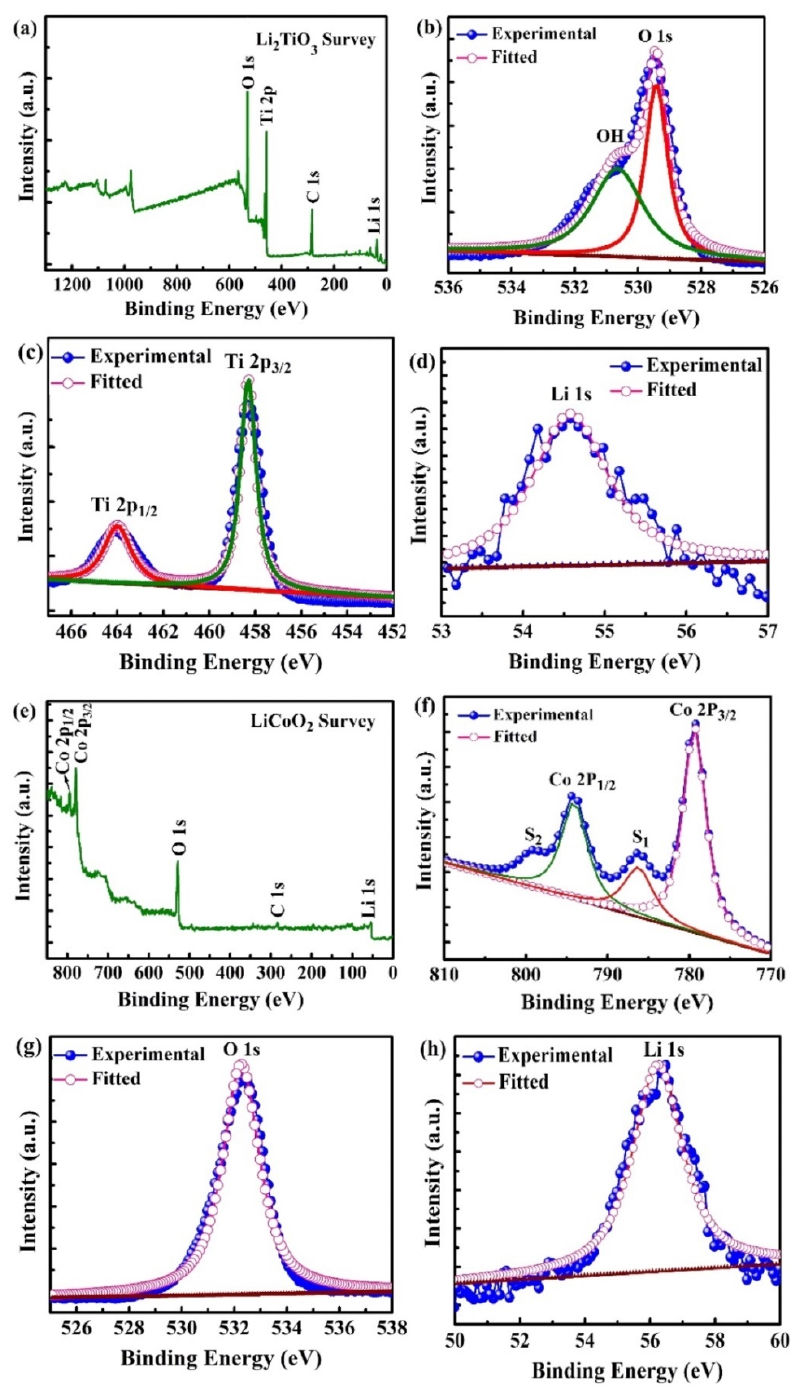
Figure 2. XPS analysis of Li 2 TiO 3 ( a-d ) and LiCoO 2 (e-h). XPS survey spectrum of ( a ) Li 2 TiO 3 , high- resolution XPS spectra of ( b ) O 1s, ( c ) Ti 2p, and ( d ) Li 1s. XPS survey spectrum of ( e ) LiCoO 2 , high-resolution XPS spectra of individual elements: ( f ) O 1s, ( g ) Co 2p, and ( h ) Li 1s.